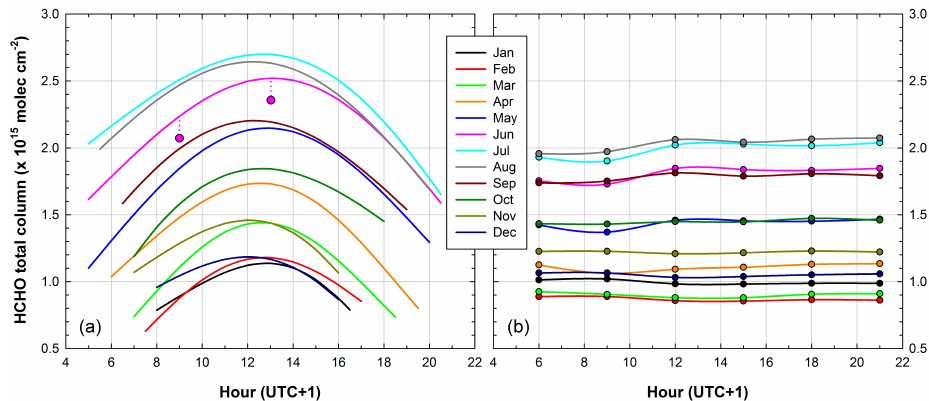
Figure 3. Monthly diurnal cycles of HCHO total columns above Jungfraujoch adjusted by the parametric model (Eq. 1) to the 1995–2015 BRUKER FTIR observations (a) and simulated by the standard run of GEOS-Chem over the July 2005–May 2013 time period (b) . The red circles in frame (a) illustrate an example of the HCHO column derived from an individual observation made in June at 13:02 (UTC + 1) and scaled to 09:00 using the parametric model of HCHO intra-day variation (see explanation in Sect.